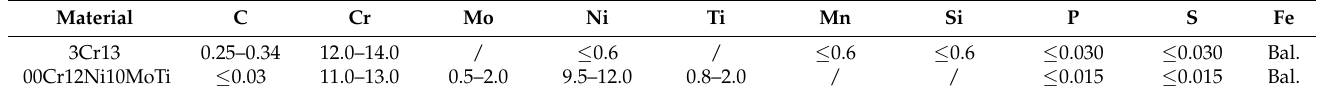
Table 1. Chemical composition content of two high-strength stainless steels (wt.%).